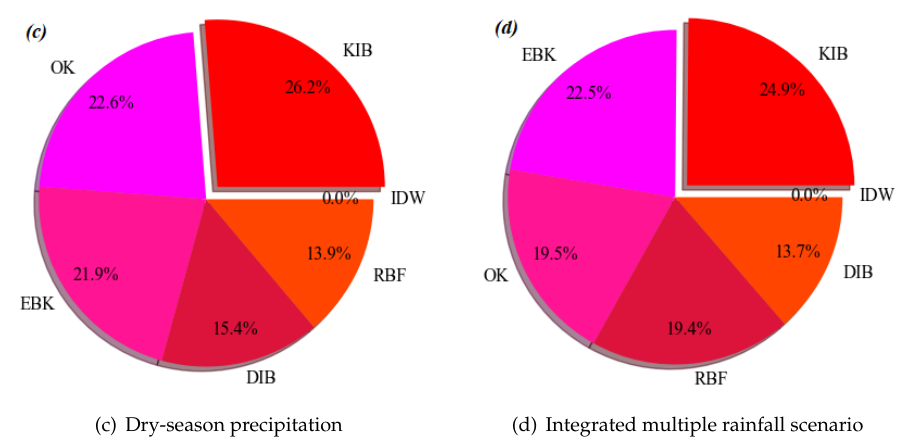
Figure 8. Relative goodness of six methods based on both different rainfall magnitudes and integrated multiple rainfall